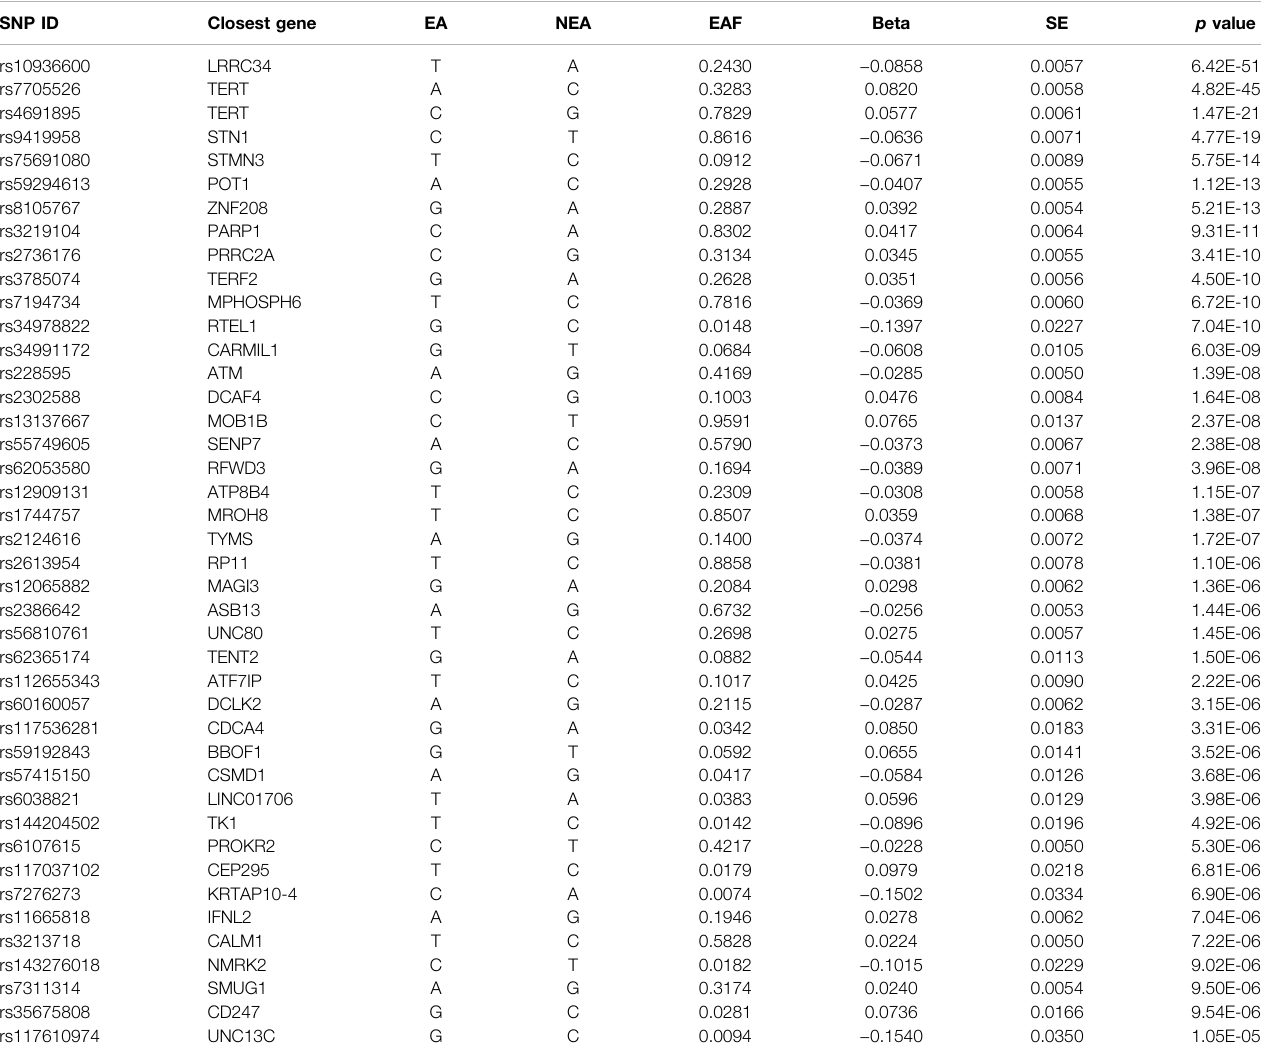
TABLE 1 | Association of 42 TL SNPs. SNP